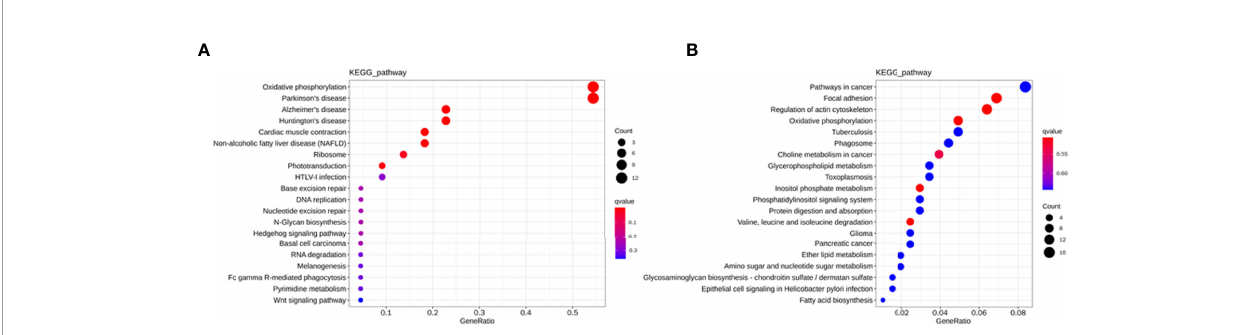
FIGURE 6 | KEGG pathway analysis for cis-acting genes (A) and trans-acting genes (B) of differentially expressed lncRNAs in T1DM and control